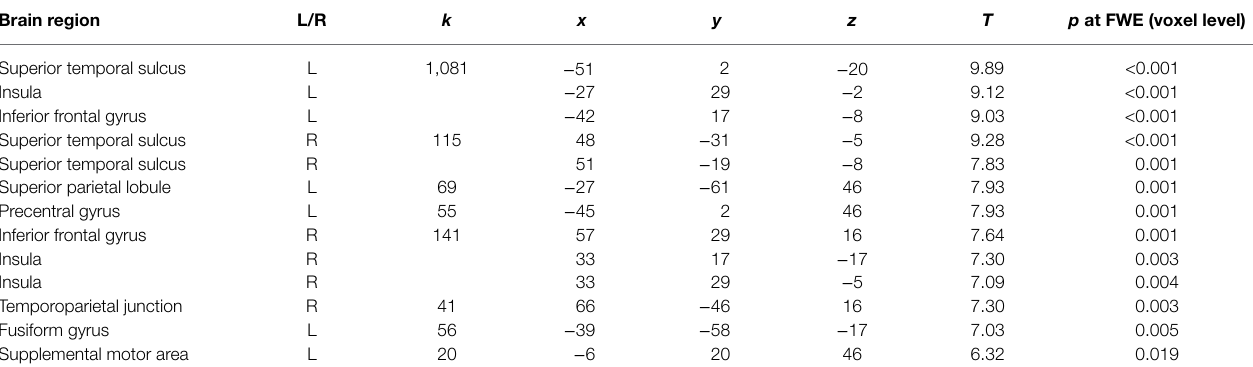
TABLE 1 | Whole-brain analysis for ToM Response > Control Response p < 0.05 FWE, k = 20. Brain region L/R k x Superior temporal